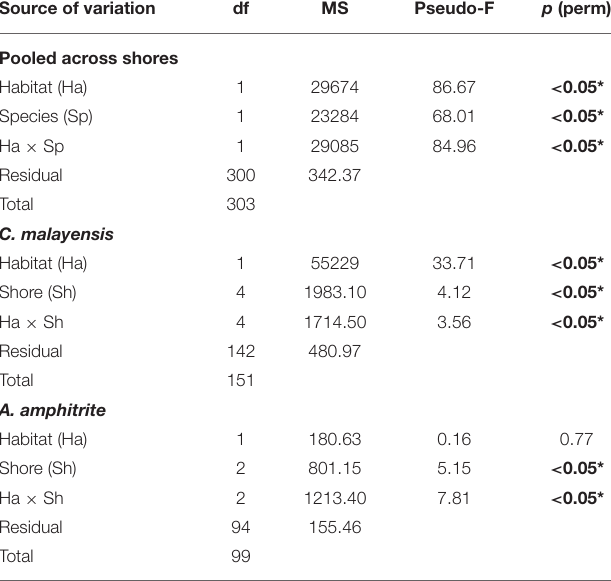
TABLE 3 | Permutational multivariate ANOVA (PERMANOVA) for the effects of habitat (rock pools and adjacent open rock surfaces), species and shore on barnacle